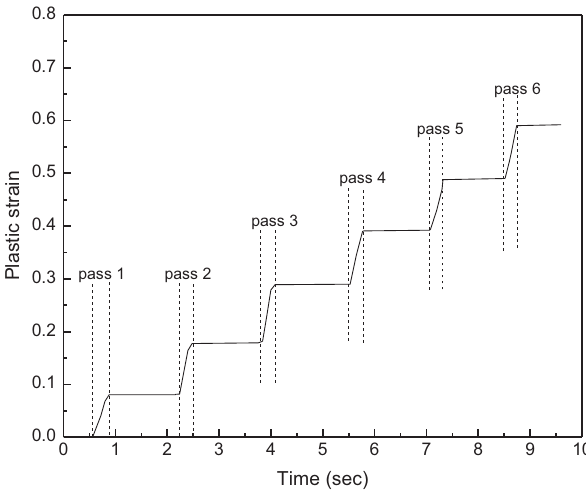
Figure 2: Plastic macro-element strain data at the 1/4 thickness position form the inner-arc of the